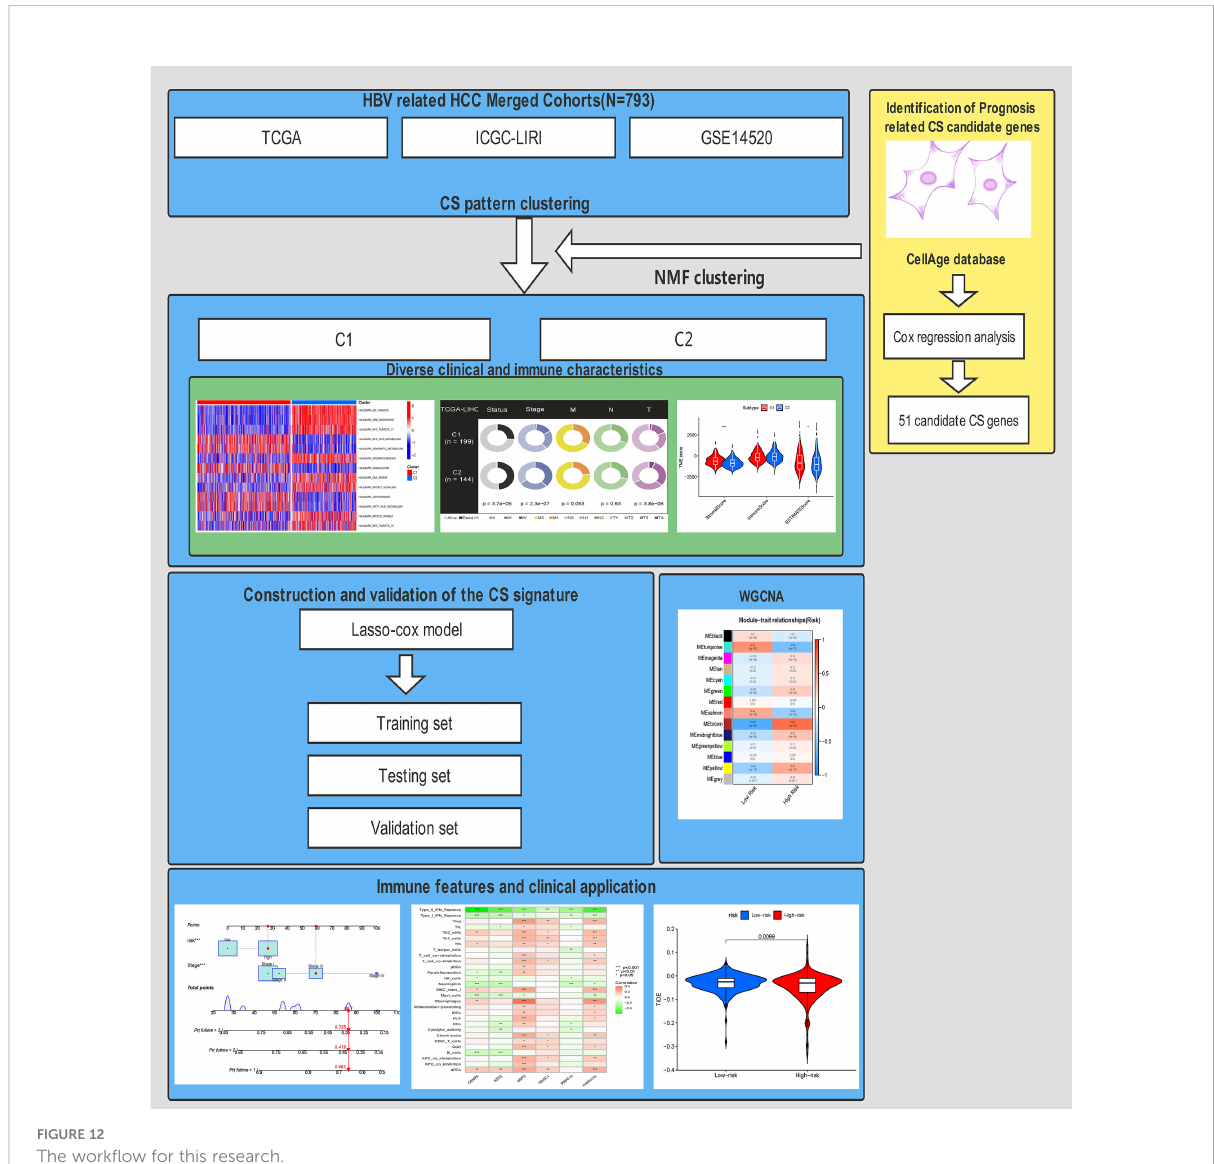
FIGURE 12 The work fl ow for this